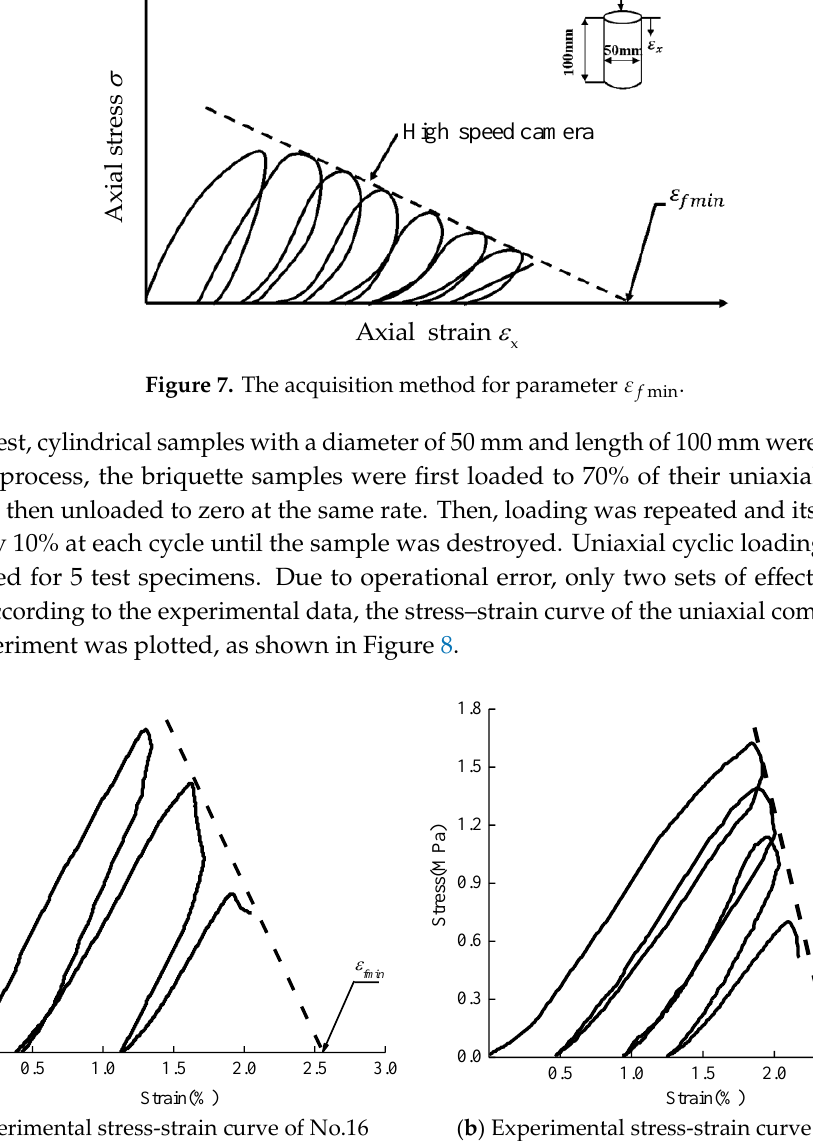
( b ) Experimental stress-strain curve of No.19 briquette under uniaxial cyclic loading Figure 8. Experimental stress – strain curve of uniaxial cyclic loading.